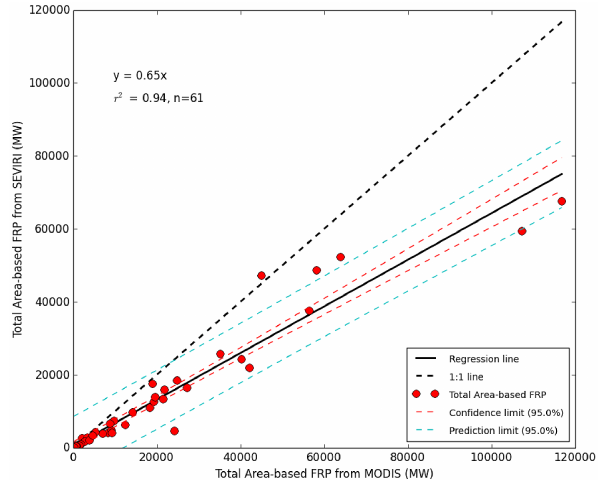
Figure 3. Relationship between regional-scale interscene FRP de- rived from all spatially matched, contemporaneous SEVIRI and MODIS FRP-PIXEL observations for the Northern Africa region (1–7 December 2009). The MODIS swath is taken as the observa- tion area. The least squares linear best fit passing through the ori- gin is shown (bold line), along with the 95% confidence intervals on the mean (light dotted line) and on the prediction of y from x (outermost lines). The 1 : 1 line is also shown (dashed). SEVIRI tends to generally underestimate regional-scale FRP, primarily due to the non-detection of the lowest FRP fire pixels, many of which MODIS can detect. However, the degree of underestimation is rel- atively small as described by the slope of the linear best fit to the